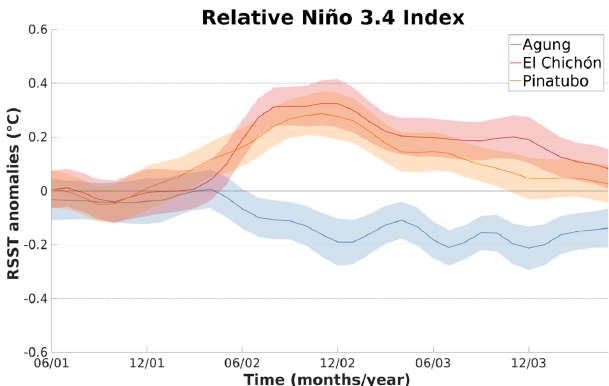
Figure A2. Ensemble mean changes in the relative Niño 3.4 index after each eruption. The 3-year climatology is subtracted to calculate the anomalies. Shading represent twice the standard error of the mean using an approximate 95% confidence interval.